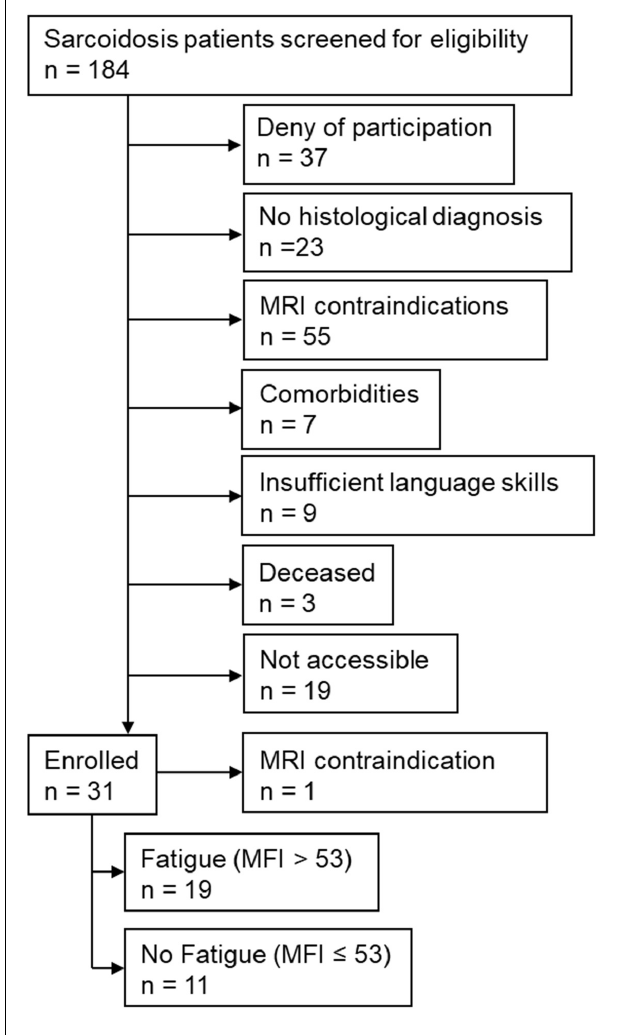
FIGURE 2 | Study flow chart. MFI: Multidimensional Fatigue Inventory; MRI: magnetic resonance